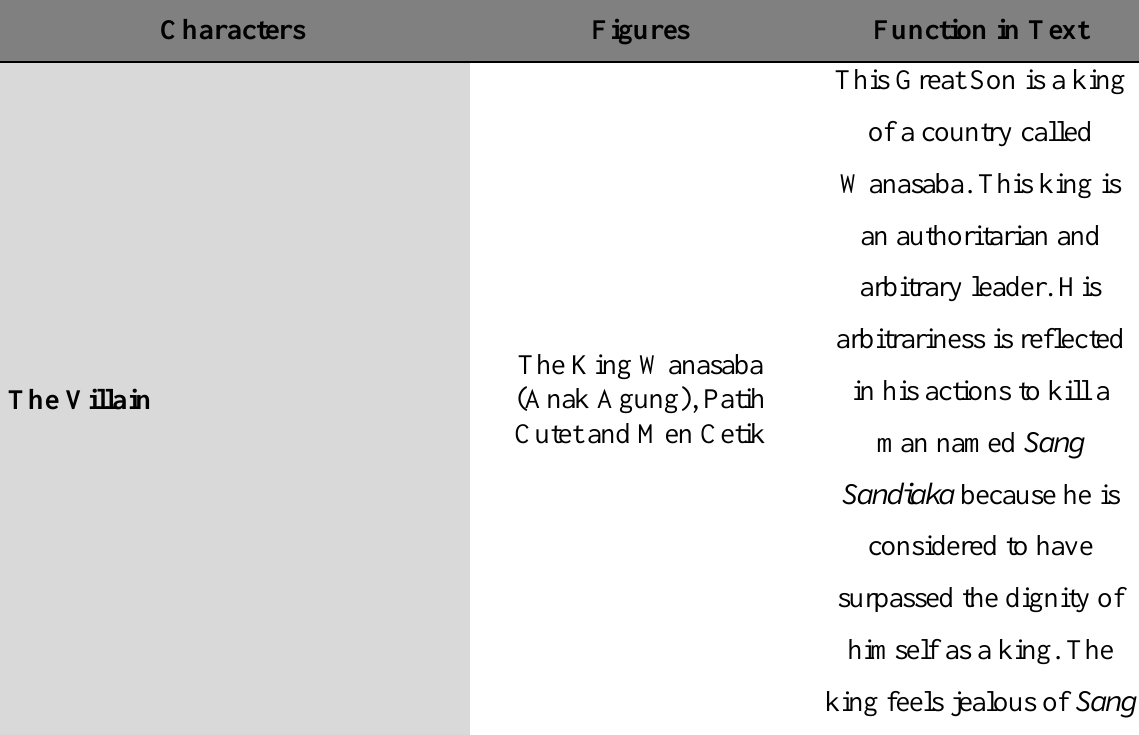
Tabel 1: The Functions of the Seven Characters in the Sang Sandiaka